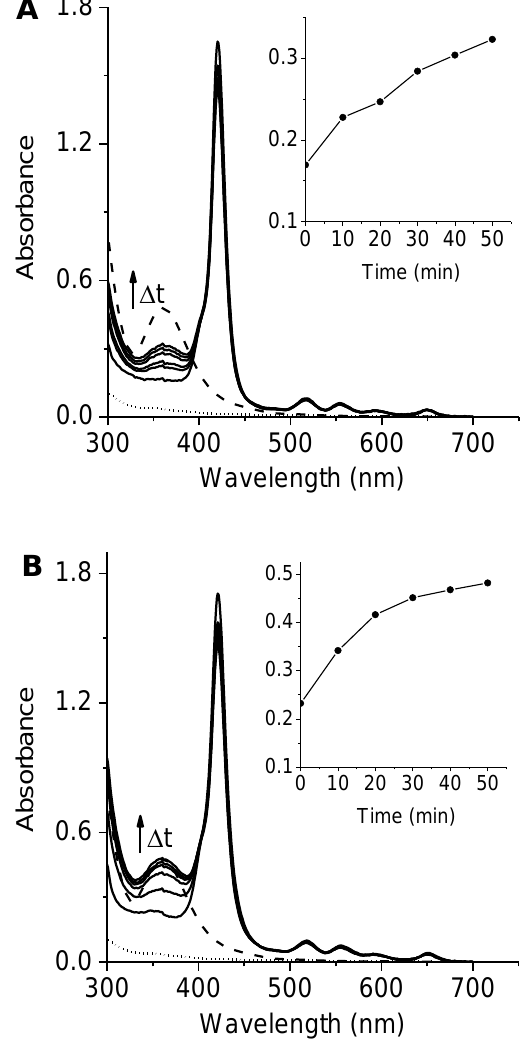
Figure 6. Absorption spectra of ( A ) 6 and ( B ) 7 containing 100 mM KI in DMF/10% after different irradiation times (0, 10, 20, 30, 40, and 50 min; solid lines) with visible light. Inset: changes in absorbance at 360 nm after different irradiation times. The dashed and dotted lines represent Lugol’s solution (20 µ M) and KI (100 mM), respectively, irradiated with visible light for 50 min. 2.6. PDI of Microbial Cells